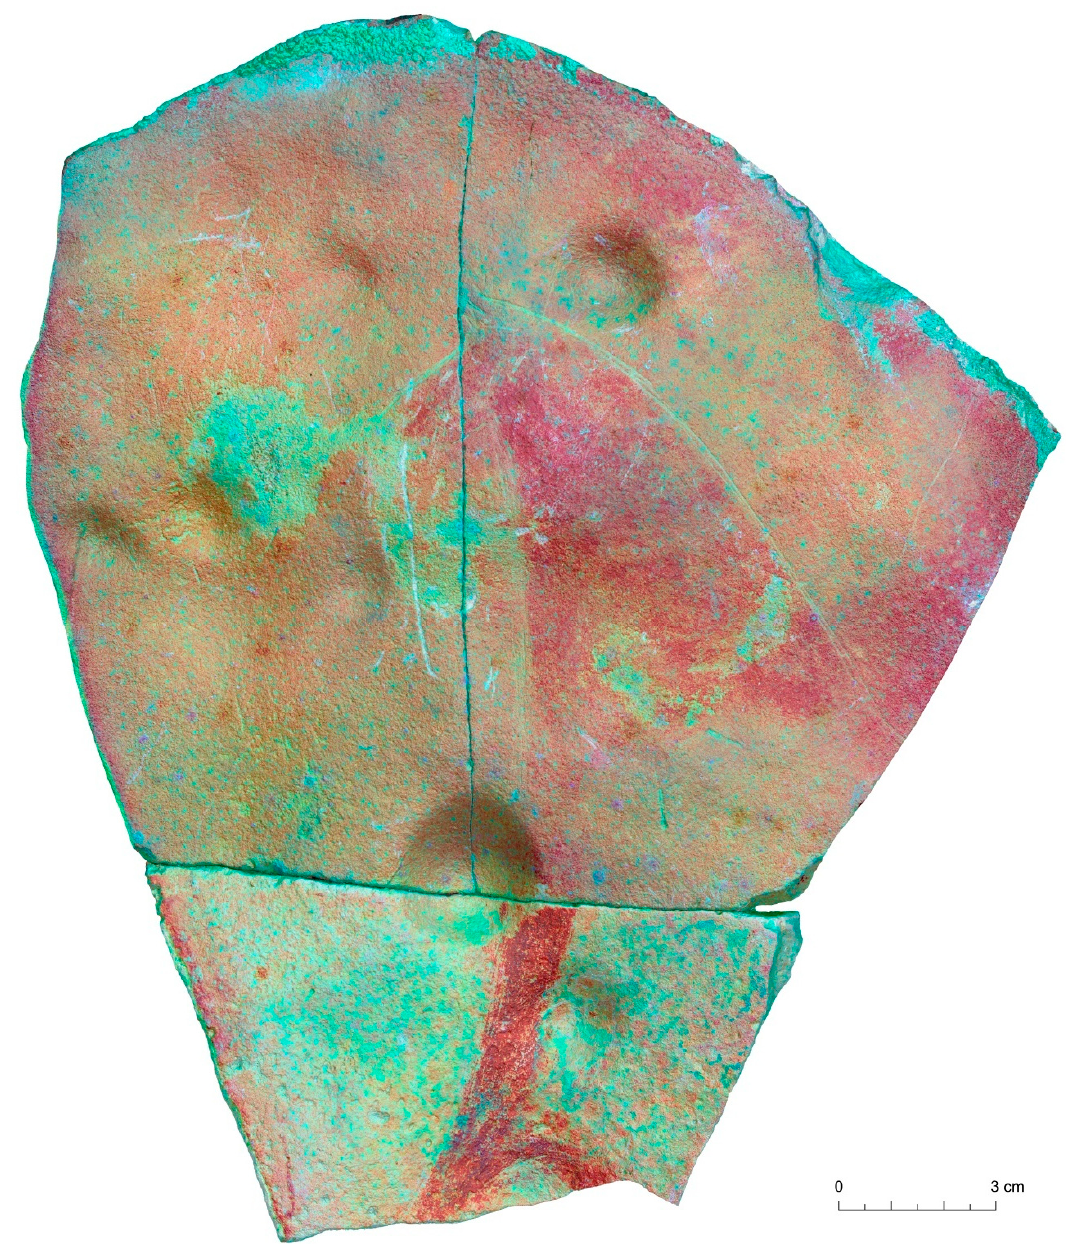
Figure 9. Plaquette 16330A, the result of superimposing the hillshade layer with a transparency of 60% on the DStretch-LRE orthophotomosaic layer.